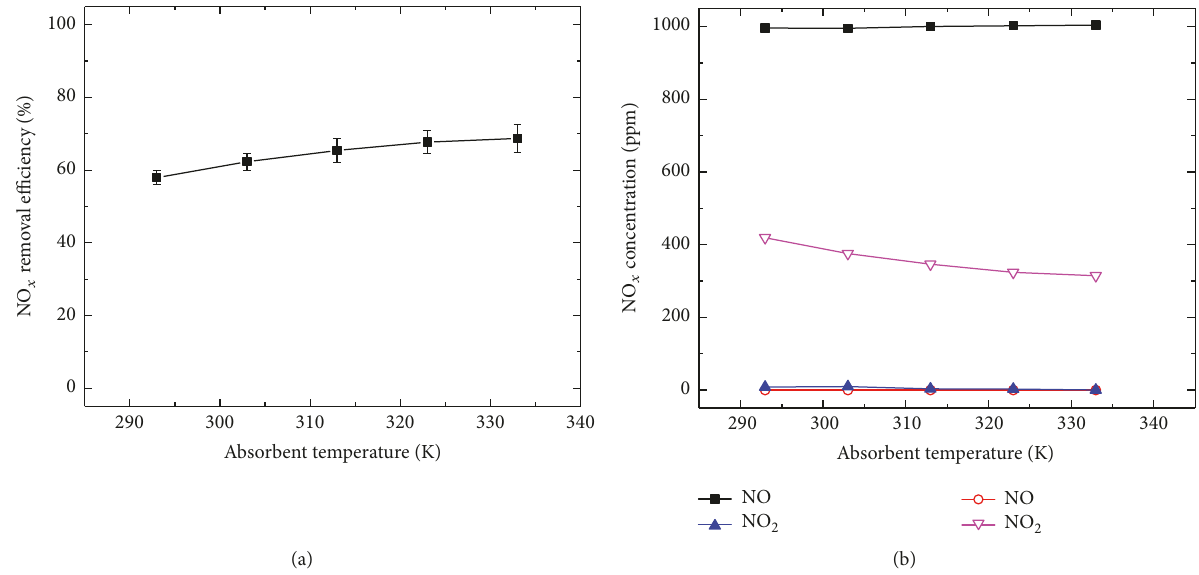
Figure 14: The change of (a) NO removal efficiency and (b) NO concentration with the absorbent temperature (gas flow is 1.25 L/min, inlet x x NO concentration is 1000 ppm, NaClO concentration is 0.05 M, initial solution pH is 6, and solution temperature is 293–333 K; solid points x refer to inlet NO concentrations and open points refer to outlet NO x x